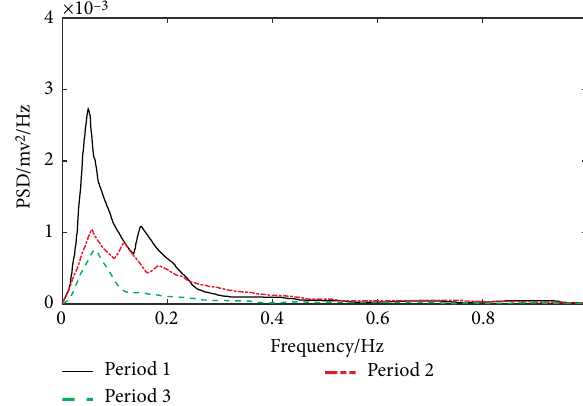
Figure 7: Comparison of RR interval series (single driving vs. master-slave task).